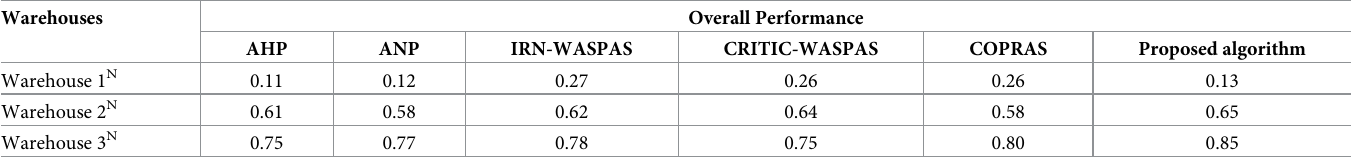
Table 2. The overall performance values for three warehouses using different